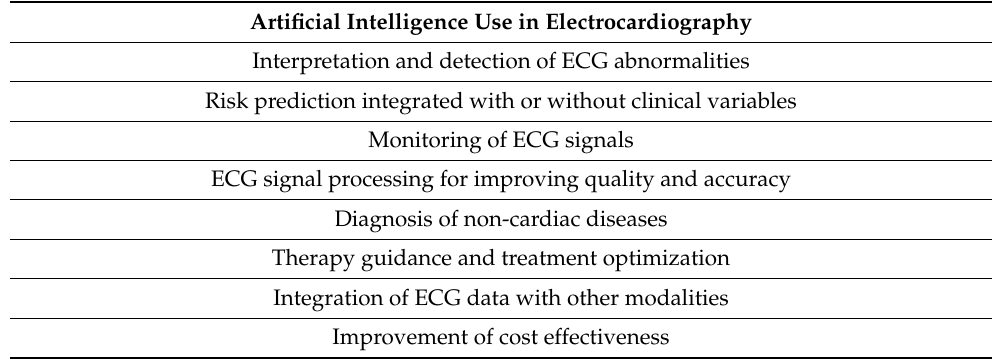
Table 1. Some areas where artificial intelligence algorithms can help clinicians in the field of electro-